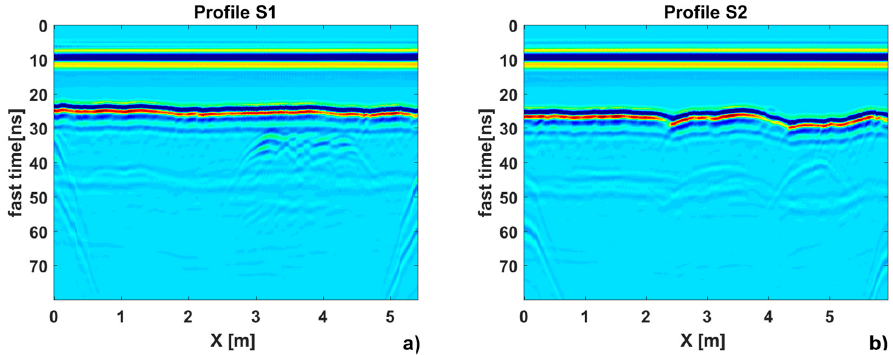
Figure 6. Raw radargram collected along S1 ( a ) and S2 ( b ) profiles.